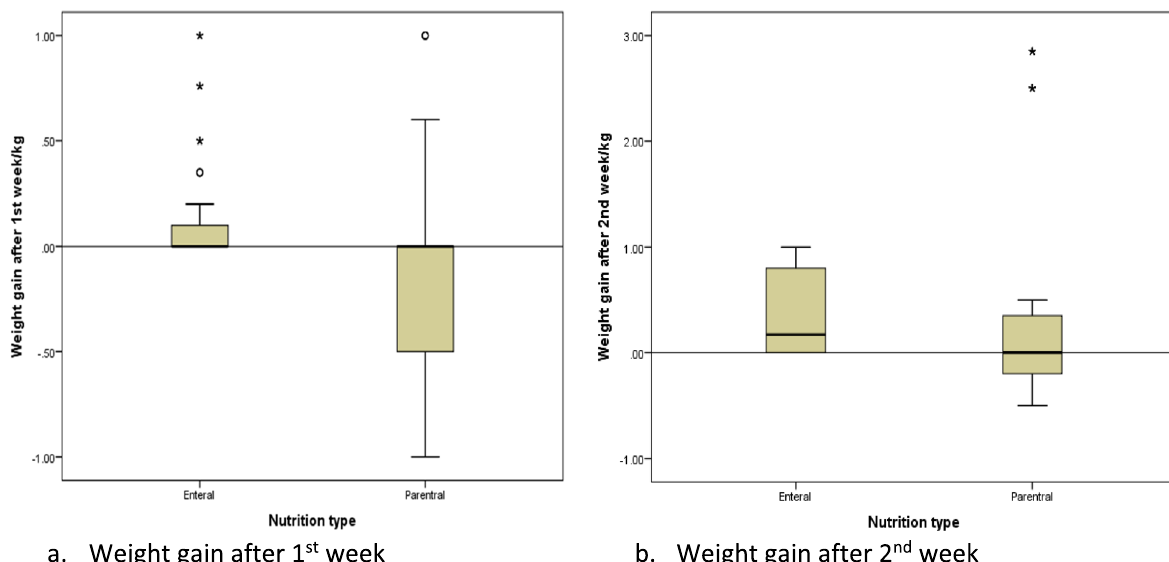
Fig. 1 Weight gain in different times of the studied patients regarding nutrition type